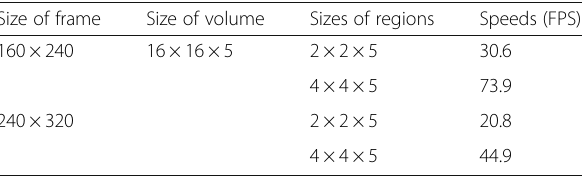
Table 3 Comparisons of the computational efficiency of HOCG descriptors with different parameters